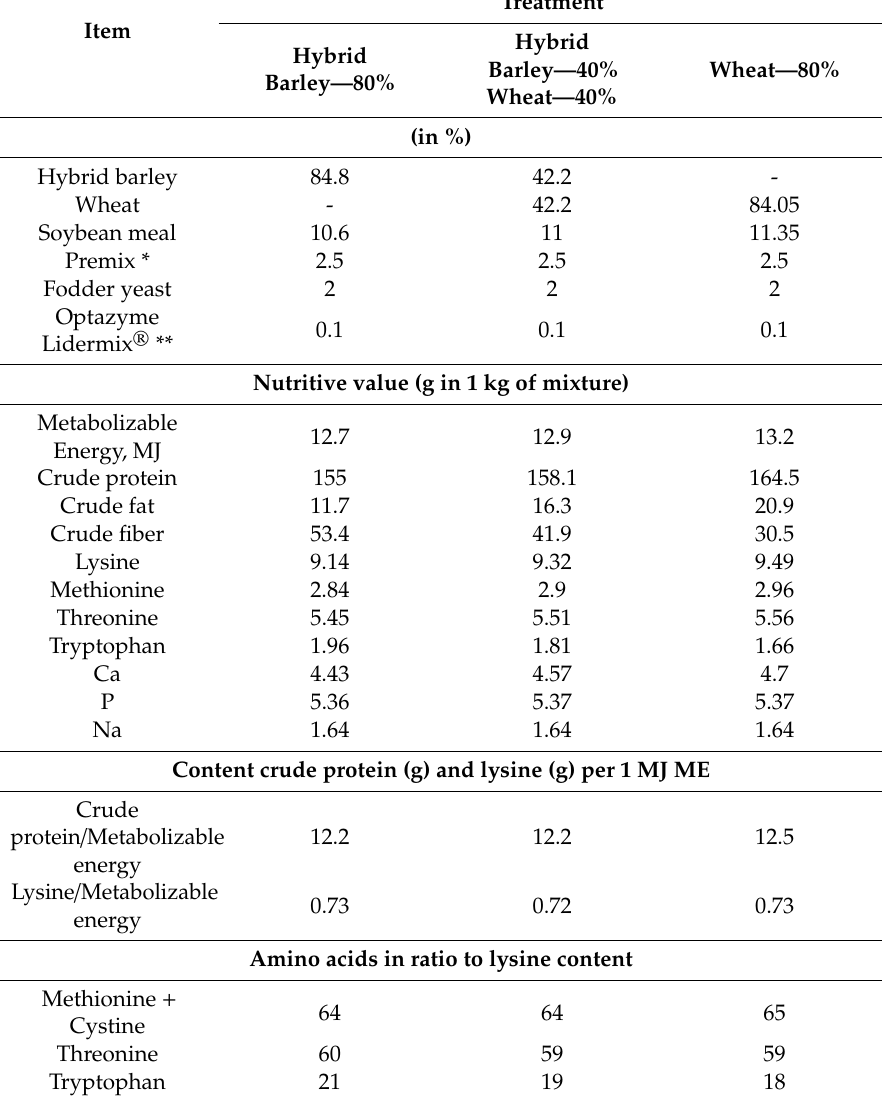
Table 3. Chemical composition and nutritive value of the diets for fattening pigs.